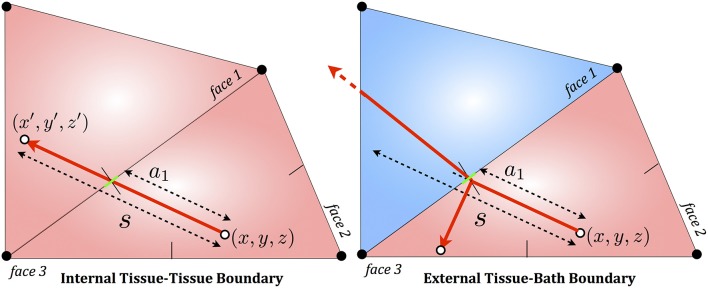
2D schematic of triangular face boundary interaction algorithm for a photon packet attempting to propagate through a boundary between two tissue elements (left) or between a tissue element and a bath element (right). s represents the total step-size of the packet, attempting to move between its initial position at x, y, z to its final position at x′, y′, z′. Moving along this trajectory, it encounters a boundary face (face 1), at a distance a1 from x, y, z. Note that distances to other faces 2 and 3 (a2 and a3) are negative. The site of interaction is shown by a thin green line. In the case of two tissue elements (left), the packet's path is undisturbed and it continues to move its remaining step-size (s − a1) in the adjacent element into which it passes. In the case of the boundary between tissue and bath (right) the photon packet experiences either reflection back into the tissue element, or transmission into the bath, subject to refraction.